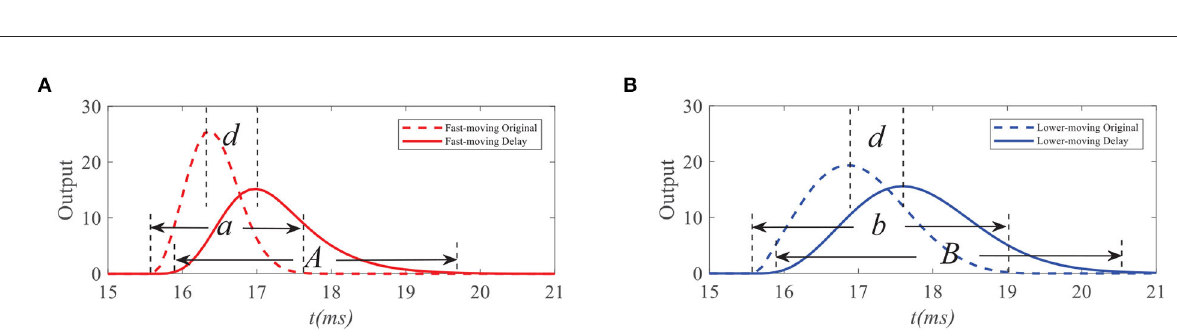
Figure 3 simulates the neuron responses to the STMD